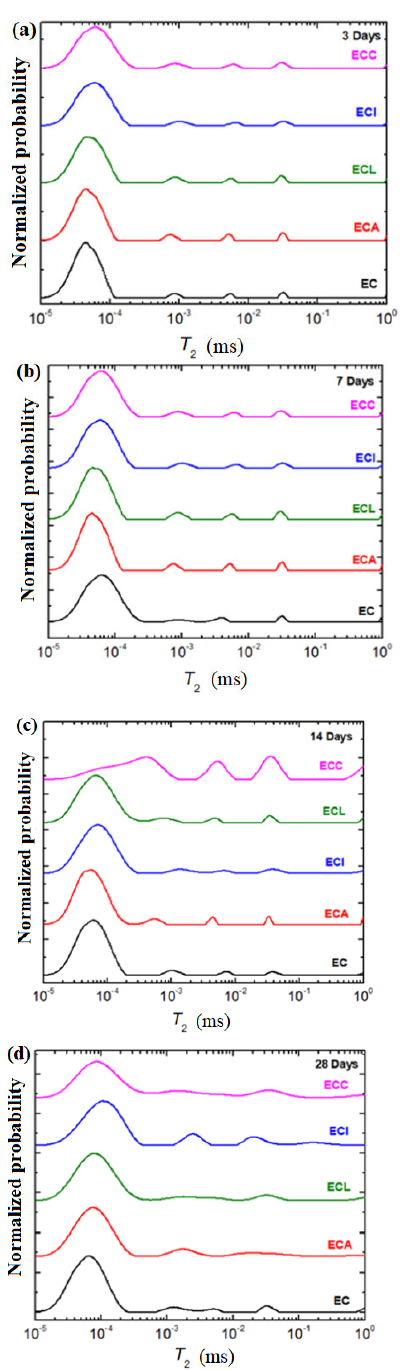
Figure 8. The relaxation time distributions of expired cement and composite ‐ expired cement ma ‐ terials (ECL: Lead composite ‐ expired cement, ECI: Iron composite ‐ expired cement, ECA: Ash (ECL: Lead composite-expired cement, ECI: Iron composite-expired cement, ECA: Ash composite- composite ‐ expired cement, ECC: Cash iron composite ‐ expired cement) at ( a ) 3 days, ( b ) 7 days, ( c ) expired cement, ECC: Cash iron composite-expired cement) at ( a ) 3 days, ( b ) 7 days, ( c ) 14 days, 14 days, and ( d ) 28 days after their preparation.